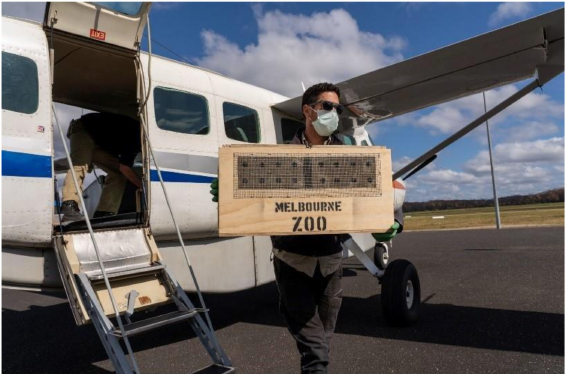
Figure A3. Eastern bristlebird extraction by Zoos Victoria staff (Darryl